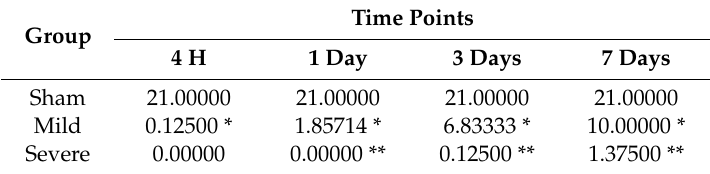
Table 1. Alterations in the locomotor rating scale scores according to the course. Time Group